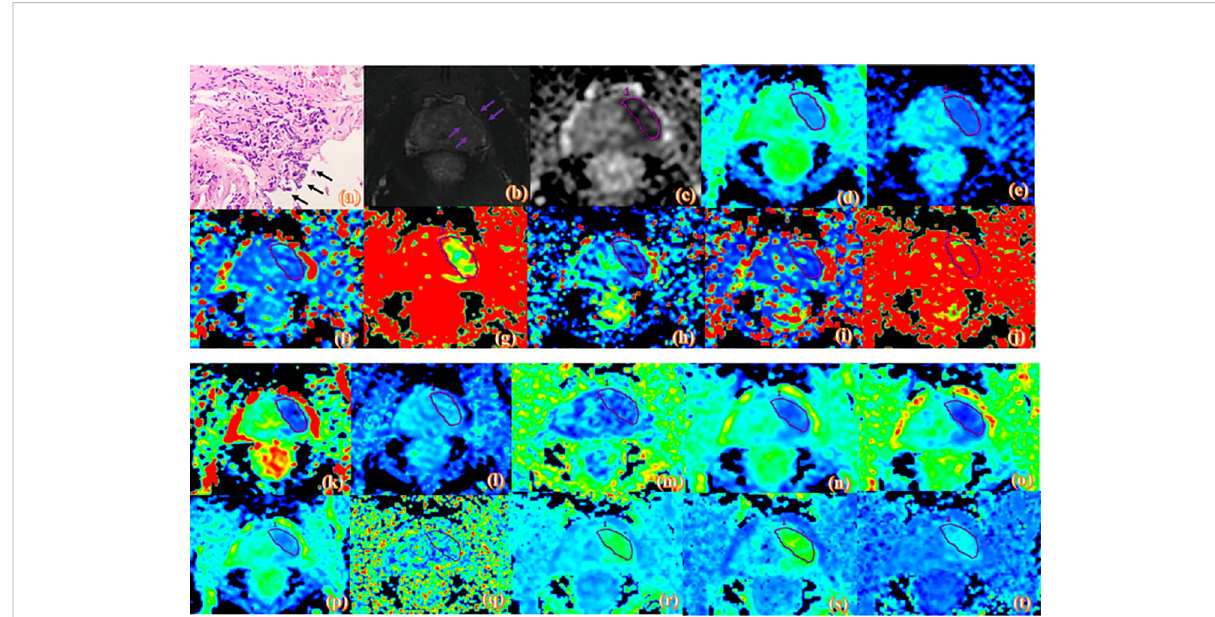
FIGURE 3 Pathologic and MR parametric maps of a 70-year-old patient (PSA level, 23.2 ng/mL; postoperative Gleason score, 4 + 5 = 9) with positive surgical margins. Neoplastic cells are indicated by black arrows breaking through the edge of the ink blot on the histologic map (20 × 10 magni fi cation). (A) . T2WI map is shown (B) , lesion is indicated by pink arrows. ADC map is shown (C) , IVIM maps are shown (D – L) and DKI maps are shown (M – T) . Lesions are indicated by pink ROI. ADC ME value is 0.788×10 -3 mm 2 /s, ADC BE value is 0.592×10 -3 mm 2 /s, D mono value is